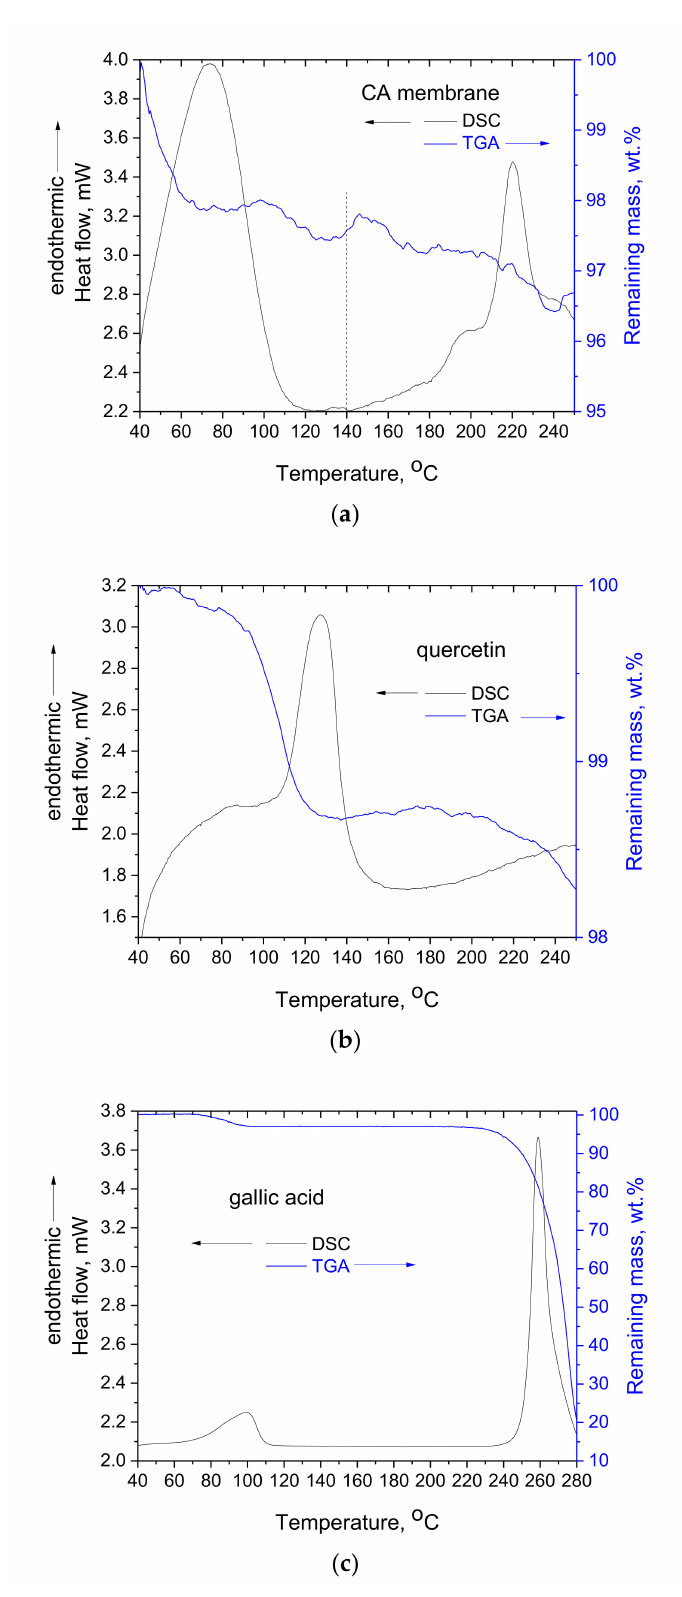
Figure 3. DSC and TGA curves of CA membrane ( a ), quercetin ( b ) and gallic acid ( c